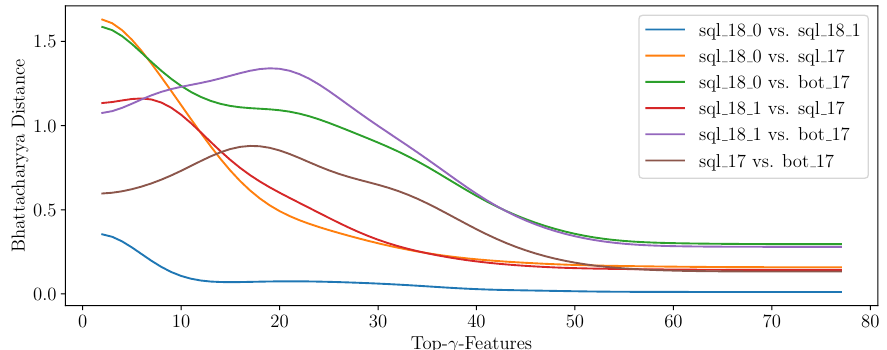
Figure 13. Smoothed γ -dependency curves using Gaussian Filtering for a selection of similar and dissimilar attack scenarios.